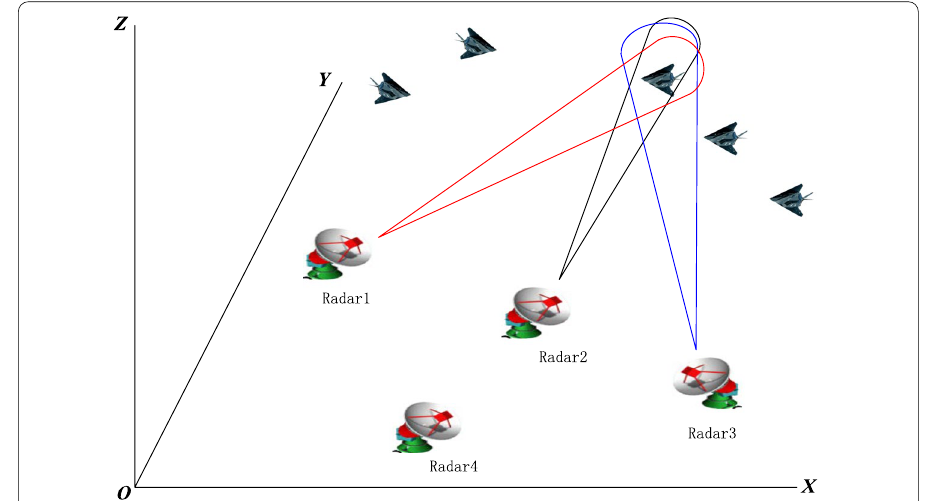
Fig. 3 The imaging geometry of radar network